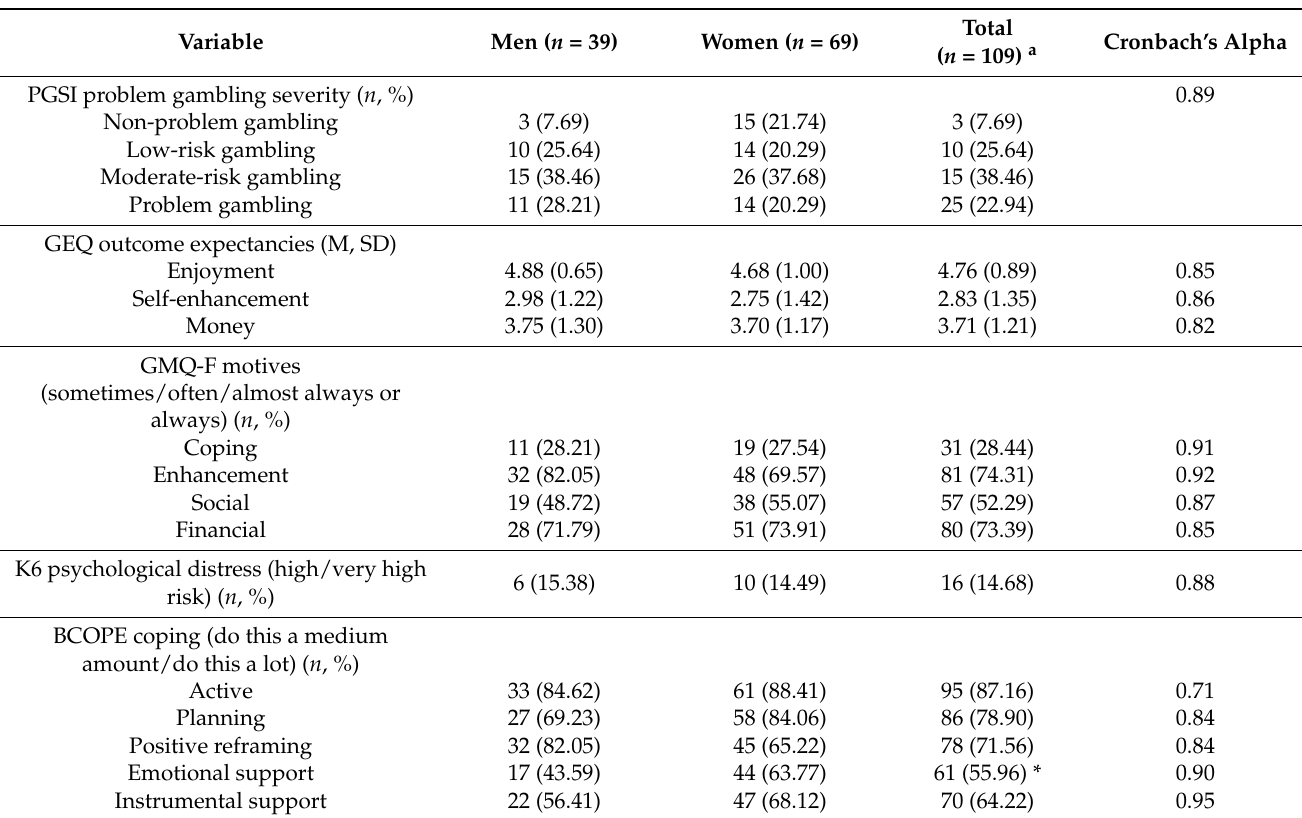
Table 3. Pre-EMA descriptive statistics for key